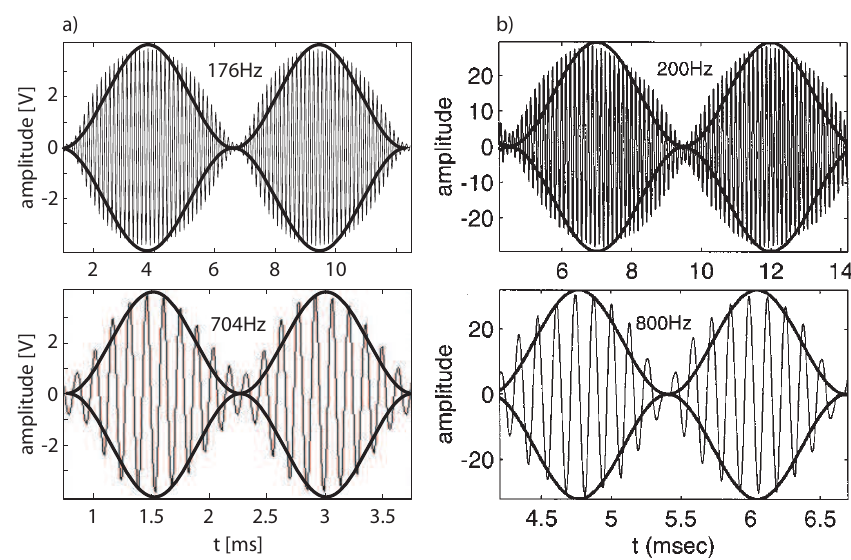
Figure 8 . Envelope distortions of 100% amplitude-modulated input tones (bold lines: ideal sinusoidal envelopes). a) electronic Hopf cochlea: Measurement: f